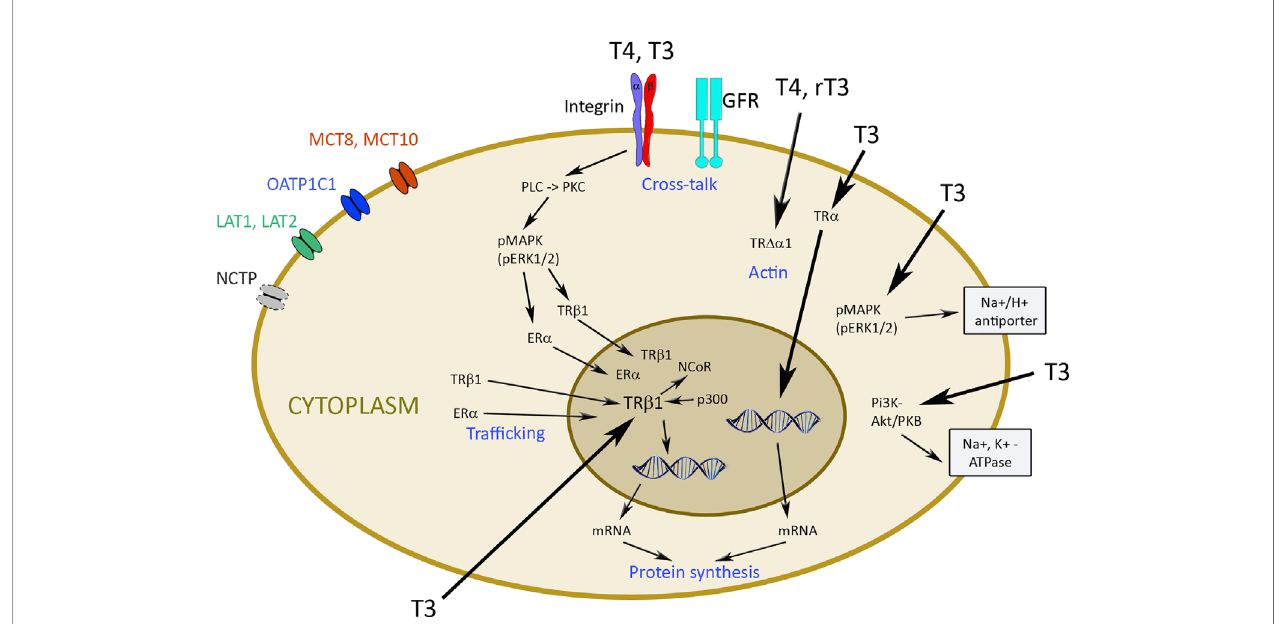
FIGURE 2 | Transporters and mechanisms of genomic and non-genomic actions of thyroid hormones. TH enters cells by diffusion or via transporters like monocarboxylate transporter MCT8 and MCT10, organic anion transporting polypeptide (OATP)1C1, L-amino acid transporter (LAT) 1 and 2, and Na+/taurocholate cotransporting polypeptide (NCTP). Hormones inside the cell can bind to thyroid hormone transporter (TR) a and b 1 and induce genomic changes via transcription. Nuclear receptor co-repressor protein (NCoR) and Adenovirus early region 1A binding protein p300 (p300) are involved in this process. Non-genomic regulation occurs by binding to integrin a v b 3 with activation of phospholipase C (PLC), protein kinase C (PKC), phosphorylated mitogen-activated protein kinase (pMAPK), and extracellular signal-regulated kinase (ERK) to induce traf fi cking of the phosphorylated TR b 1 and estrogen receptor (ER) into the nucleus. Cross-talk of a v b 3 integrin with growth factor receptors (GFR) is particularly important for cancer cells. T4 and rT3 can also act via TR Da 1 on actin, and T3 through pMAPK/ERK1/2 on Na + /H + antiporter and via phosphatidyl-inositol 3 kinase (PI3K) and Akt/protein kinase B (PKB) on Na + /K +